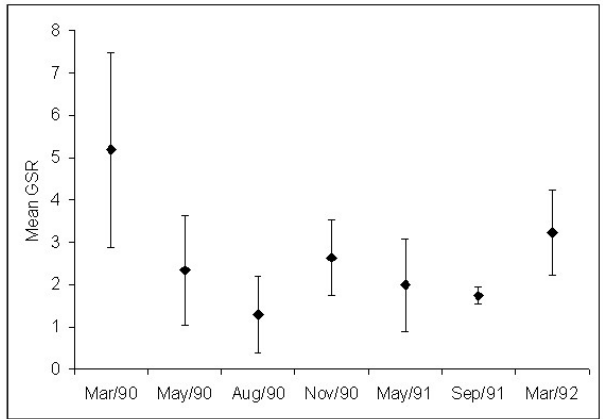
Fig. 10 . Potential batch fecundity of the Bay whiff in the Mamanguá Inlet. Bars= standard deviation.